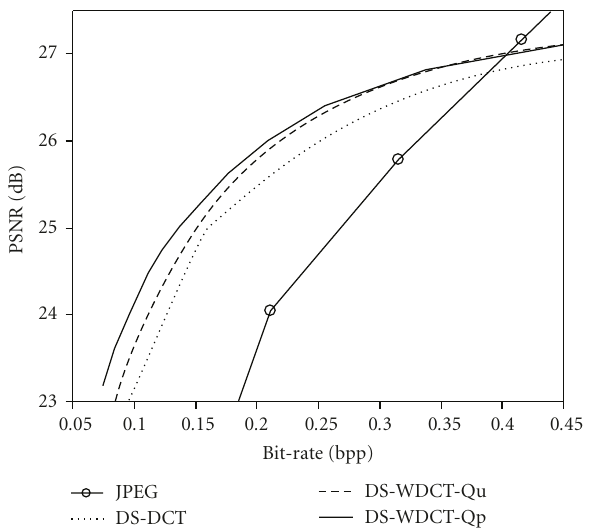
Figure 3: PSNR versus bit-rate for the Barbara image of size 512 × 512.